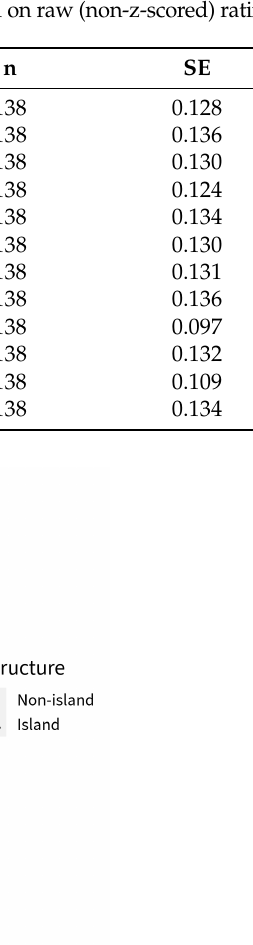
Table 2. Descriptive statistics for Experiment 1 results. Mean is calculated on raw (non-z-scored) ratings.